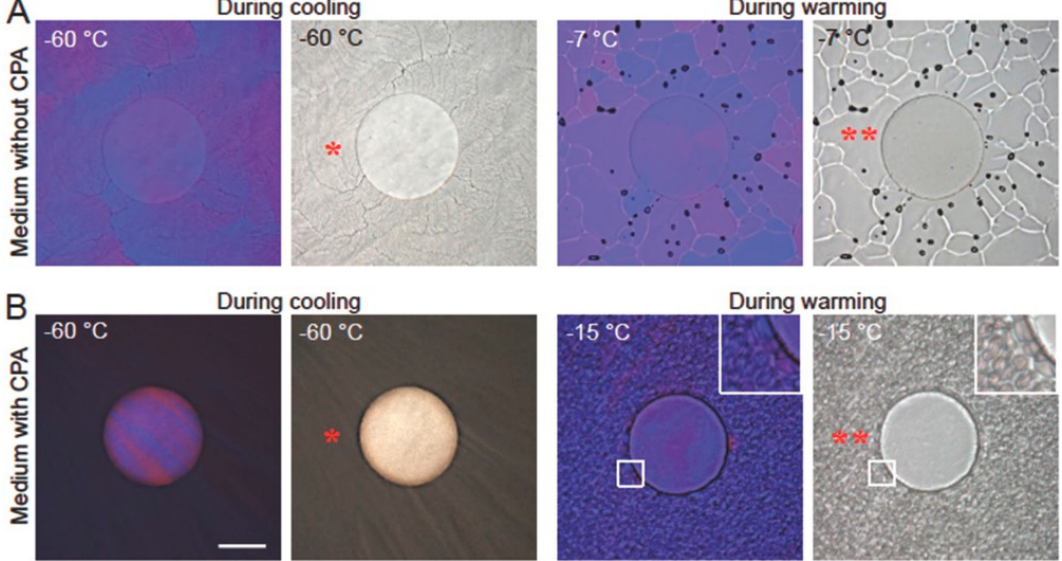
Figure 1. The intracellular ice was hindered in an alginate hydrogel microencapsulation [36]. ( A ) without CPA; ( B ) with CPA; CPA: 1.5 mol/L 1,2-propanediol and 0.5 mol/L trehalose; Color image: polarized; grayscale image: phase contrast; Scale bar: 100 µ